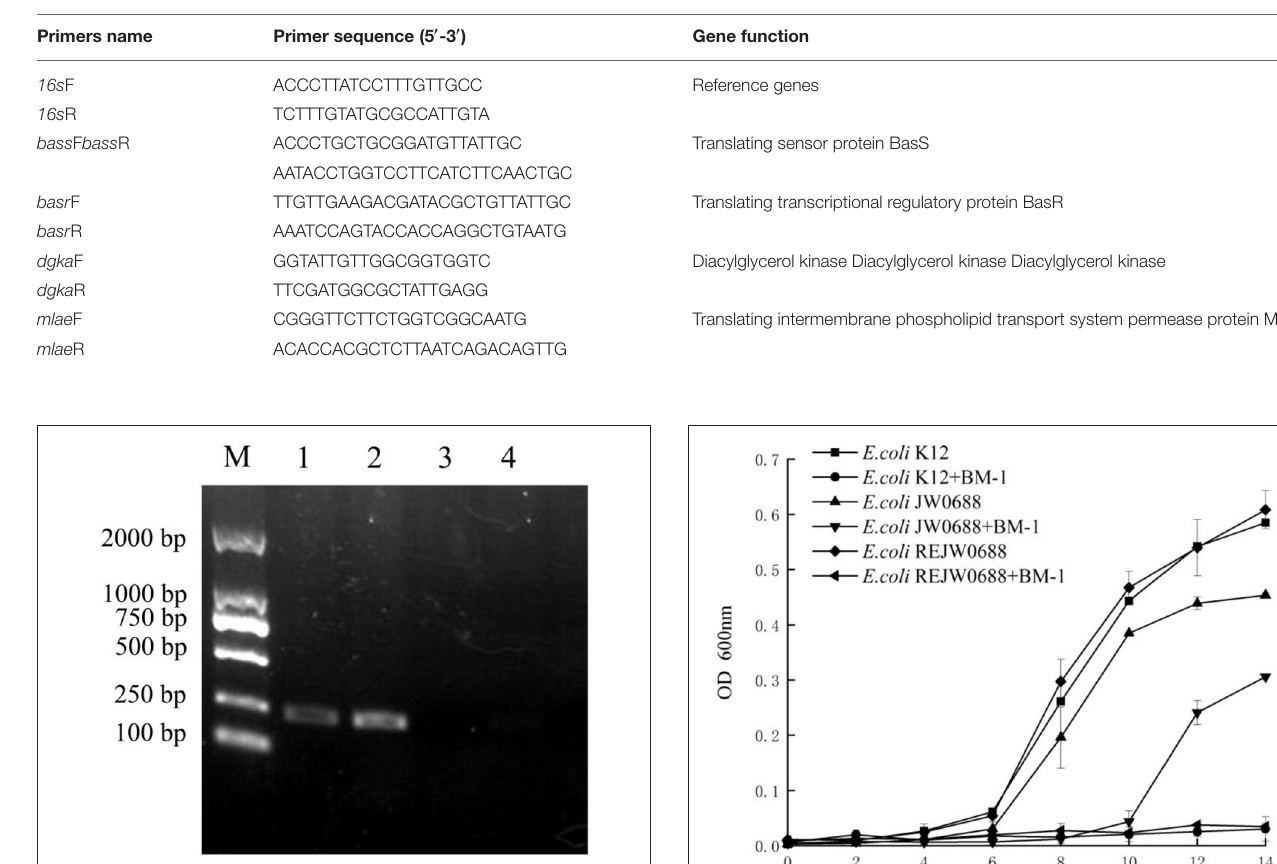
TABLE 3 | Primers for RT-qPCR.